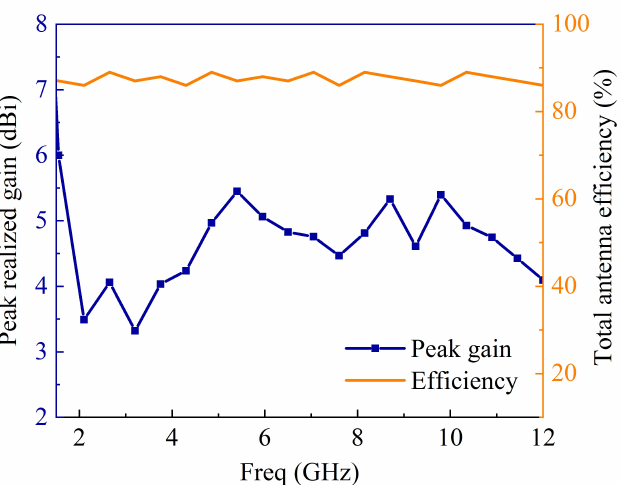
Figure 24. ( a ) Surface current distribution with metamaterial and stub. ( b ) Surface current distribu- tion without metamaterial and stub.